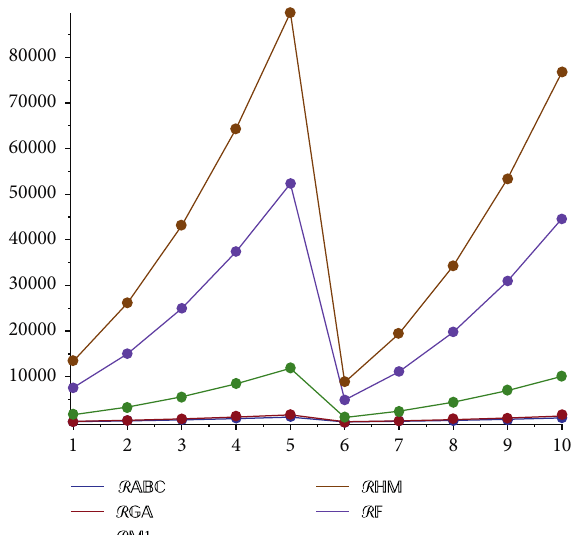
Figure 6: Graphical representation of Table